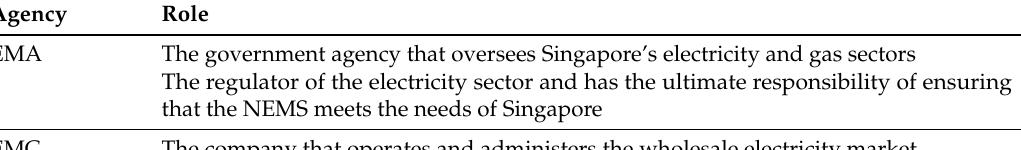
Table 4. Key players in